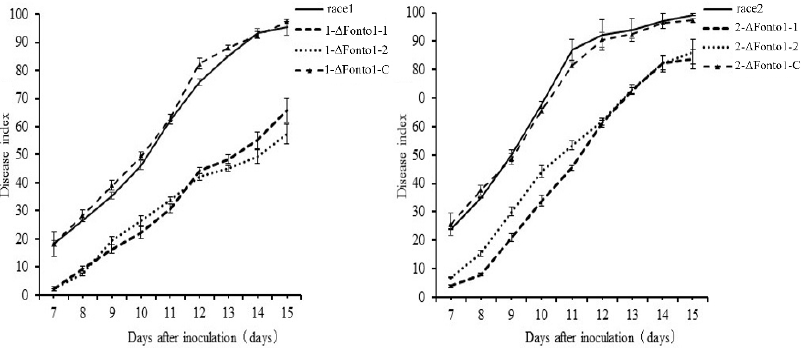
Figure 6. Disease indexes of race 1, race 2 and their corresponding Nto1 deletion mutants (1- Disease indexes of race 1, race 2 and their corresponding Nto1 deletion mu- Δ Fonto1-1, 1- Δ Fonto1-2, 2- Δ Fonto1-1 and 2- Δ Fonto1-2) and complementation mutants (1- Δ Fonto1- tants (1- ∆ Fonto1-1, 1- ∆ Fonto1-2, 2- ∆ Fonto1-1 and 2- ∆ Fonto1-2) and complementation mutants C and 2- Δ Fonto1-C) from 7 to 15 days after inoculation. Means and standard errors were calculated (1- ∆ Fonto1-C and 2- ∆ Fonto1-C) from 7 to 15 days after inoculation. Means and standard errors from three independent experiments. were calculated from three independent